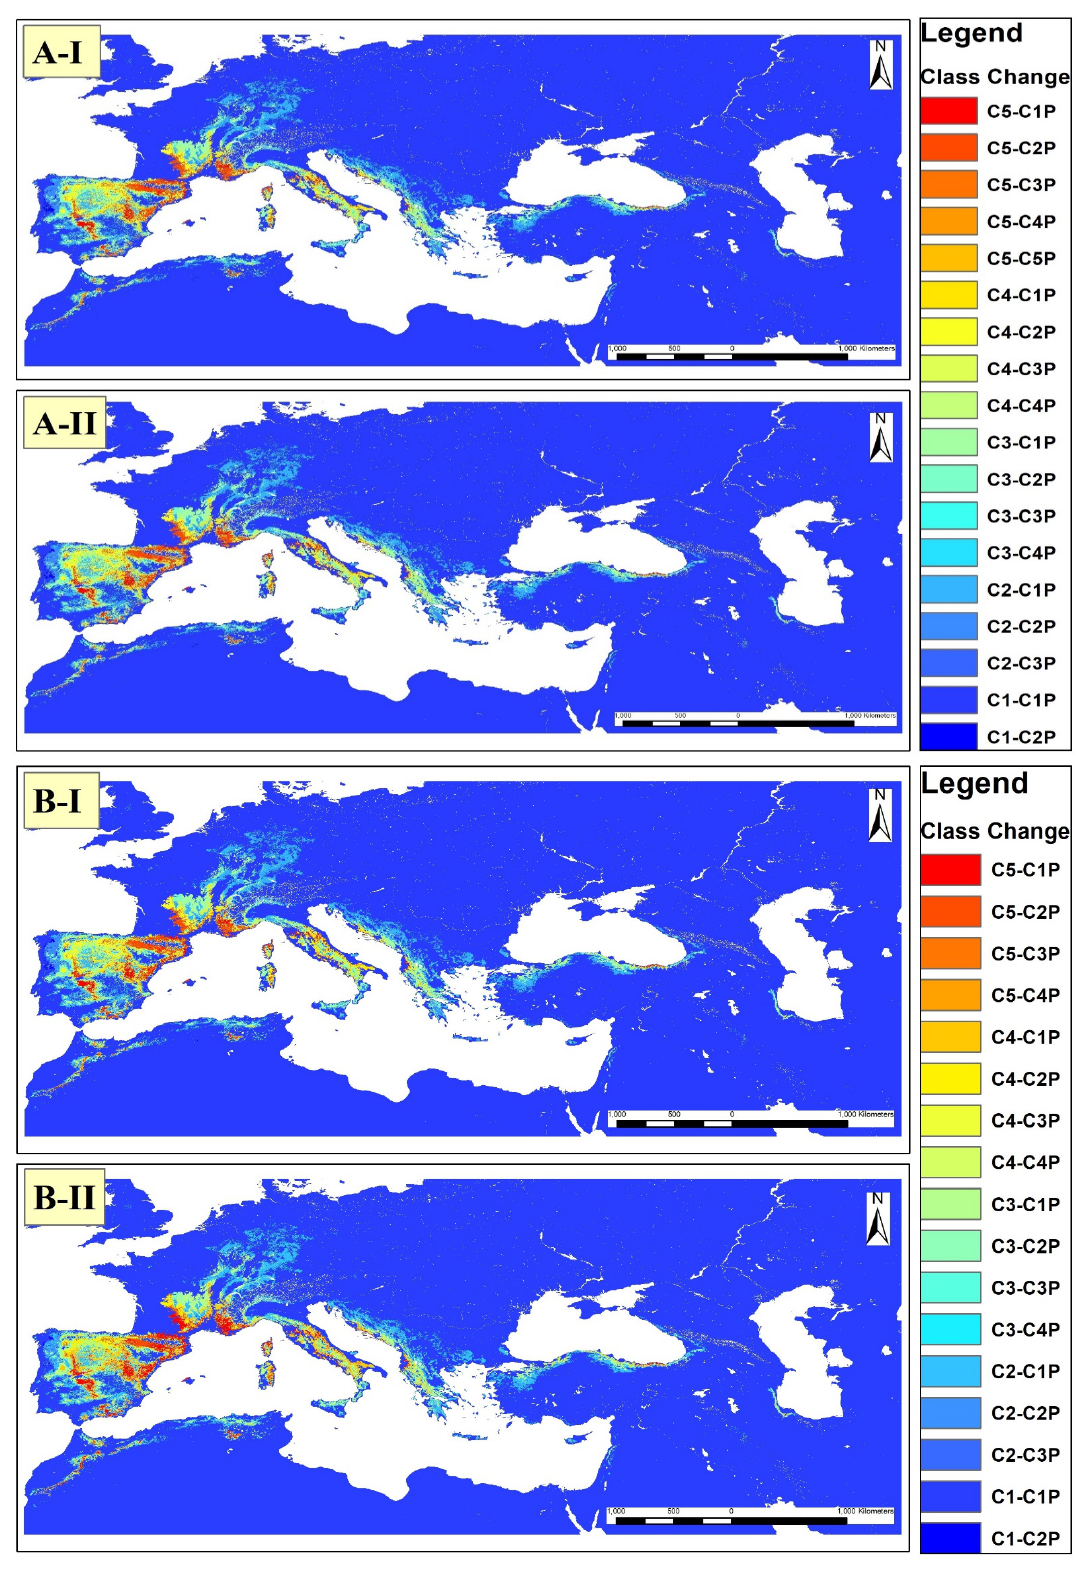
Figure 8. Changes in each suitability class in the future climatic conditions considering the 2 RCP scenarios 4.5 ( A ) and 8.5 ( B ) and the 2 time periods 2040/2060 ( I ) and 2060/2070 ( II ). C1, C2, C3, C4, and C5 are the suitability classes of the actual distribution. C1P, C2P, C3P, C4P, and C5P are the suitability classes for future distribution. Changes from classes C3, C4, and C5 to C1P and C2P show suitability losses.